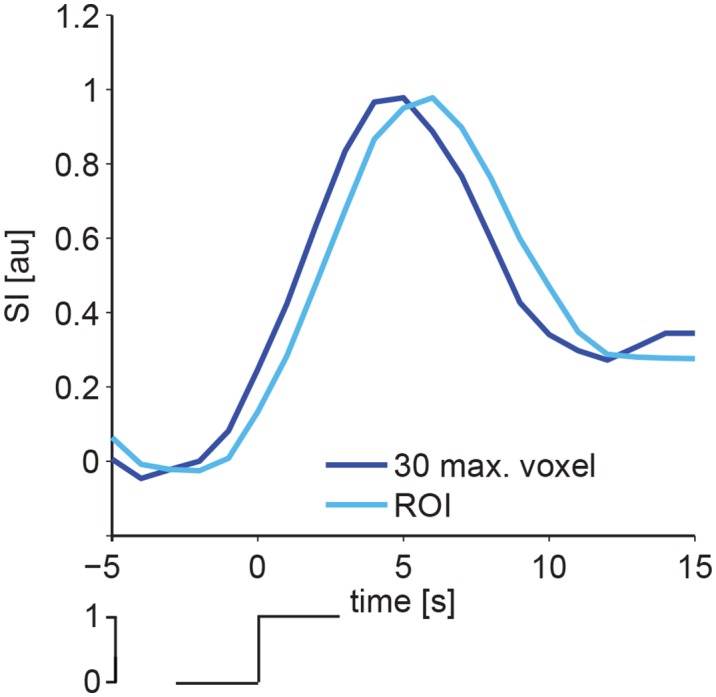
Comparison of HR extracted in the 30 most active voxel and in ROI placed in a cortical area.Timecourses of BOLD responses upon an averaged slow wave onset reveal similar signal dynamics for a ROI defined from the 30 voxel of highest intensity in the previously calculated F-maps (dark blue curve) or a ROI placed in a cortical area showing BOLD activation (light blue curve).